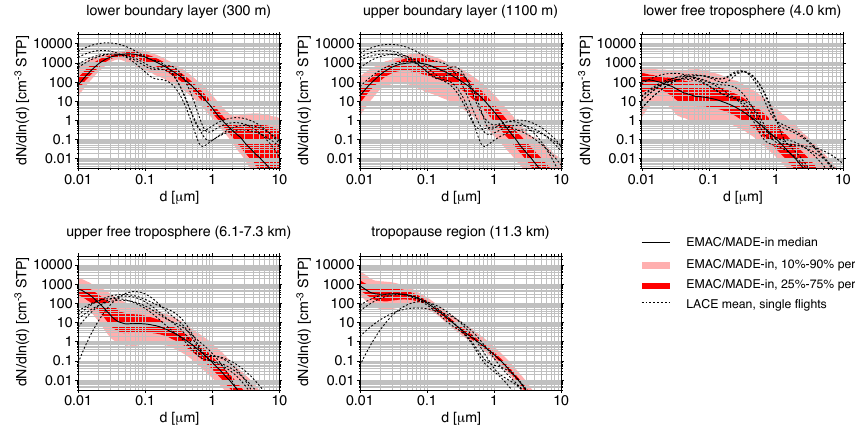
Fig. 10. Aerosol number size distributions at different altitudes measured by Petzold et al. (2002) during the LACE campaign over central Europe in August 1998 and corresponding simulated size distributions. Particle diameters correspond to dry aerosol.